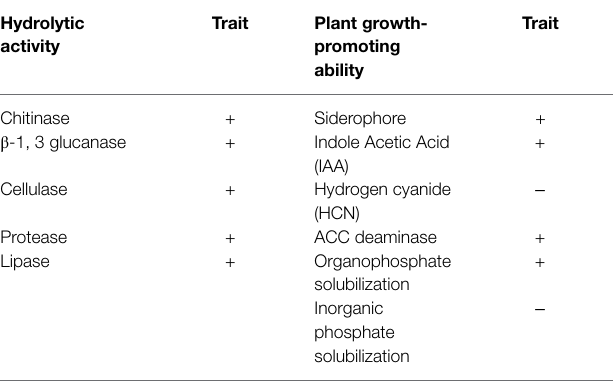
Trait Plant growth- promoting